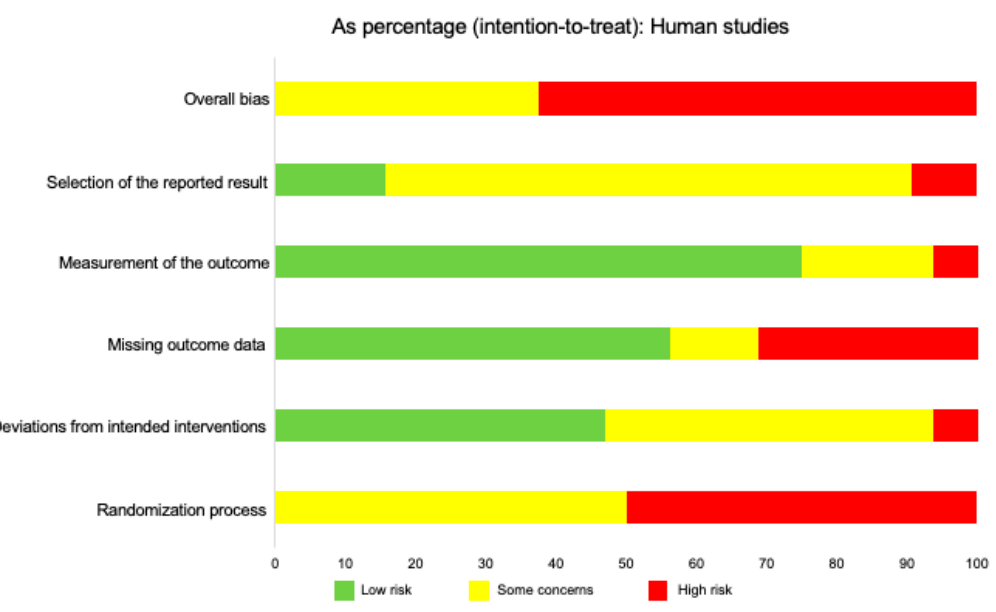
Figure 7. Risk of bias across all human studies, including brain, liver, cardiovascular, and pulmonary. This figure displays the relative percentages of intention-to-treat data of assessed risk of bias across human studies. The overall bias was determined using five categories: Selection of the reported result, measurement of the reported outcome, missing outcome data, deviations from intended interventions, and randomization process. Risk was determined as “low risk,” “some concerns,” or “high risk,” based on the Cochrane RoB 2.0 tool algorithm. The data for all human studies included 26 articles.